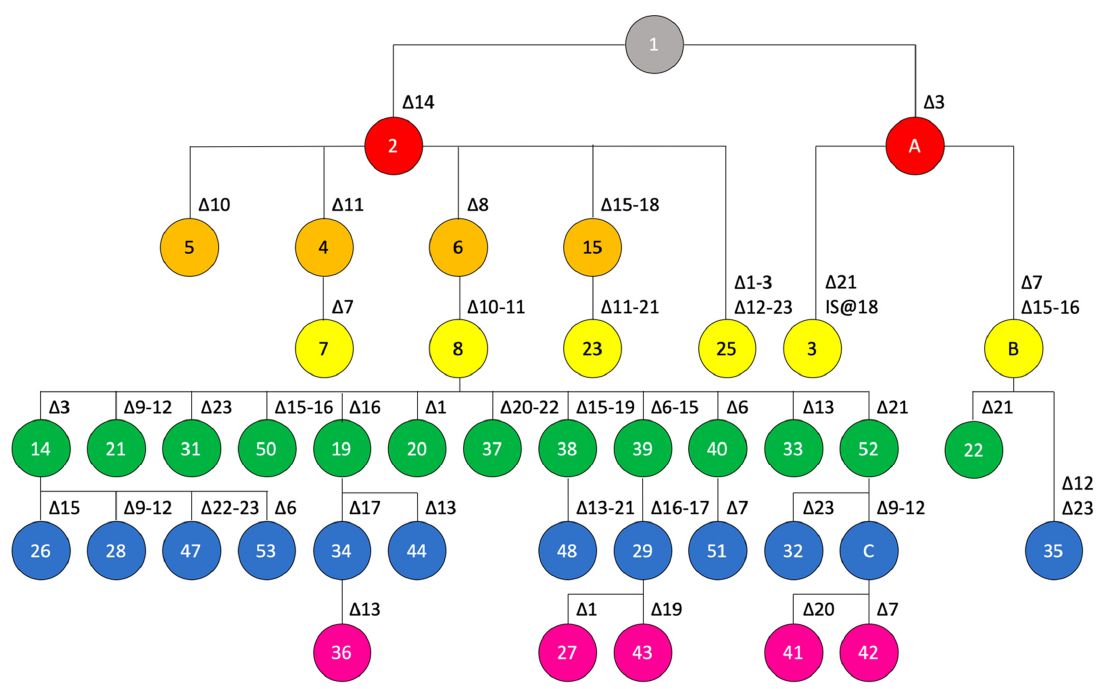
Figure 3. Genealogy of spoligotypes from pathotype-A strains. Postulated mutational events leading to the observed spoligotypes are indicated, starting from the ancestral spoligotype with all 23 spacers shown in grey on the top, with the colors indicating the number of events (from one to six events, colored in salmon, orange, yellow, green, blue, pink, respectively). Numbers of spoligotypes are indicated in the circles. Characters, i.e., A and B, indicate postulated intermediate spoligotypes that were not observed among the analyzed pathotype-A strains. Spoligotypes 7, 20, and 23 were not observed in any of the analyzed genome sequences but had been found before in strains LG116, JK148-10, LH001-3, respectively [13].